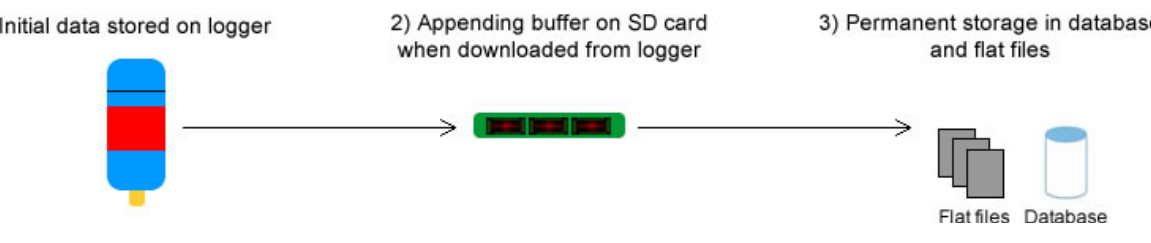
Figure 13. Overview of the Mk2 data backup and storage